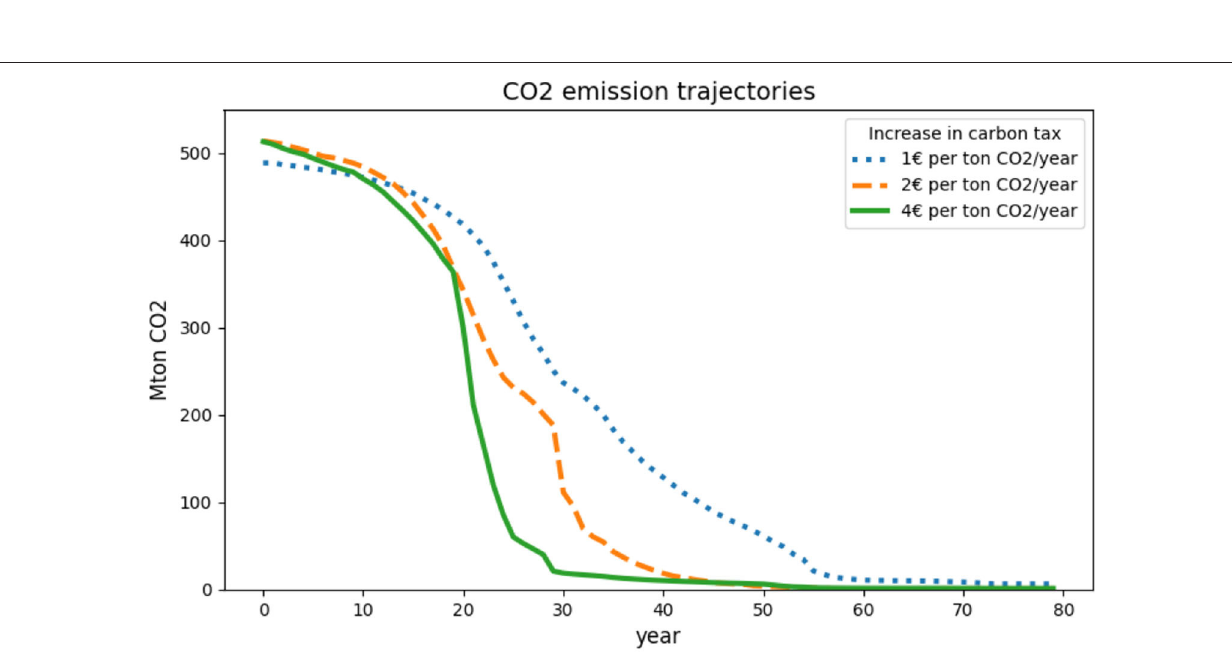
Frontiers in Climate |